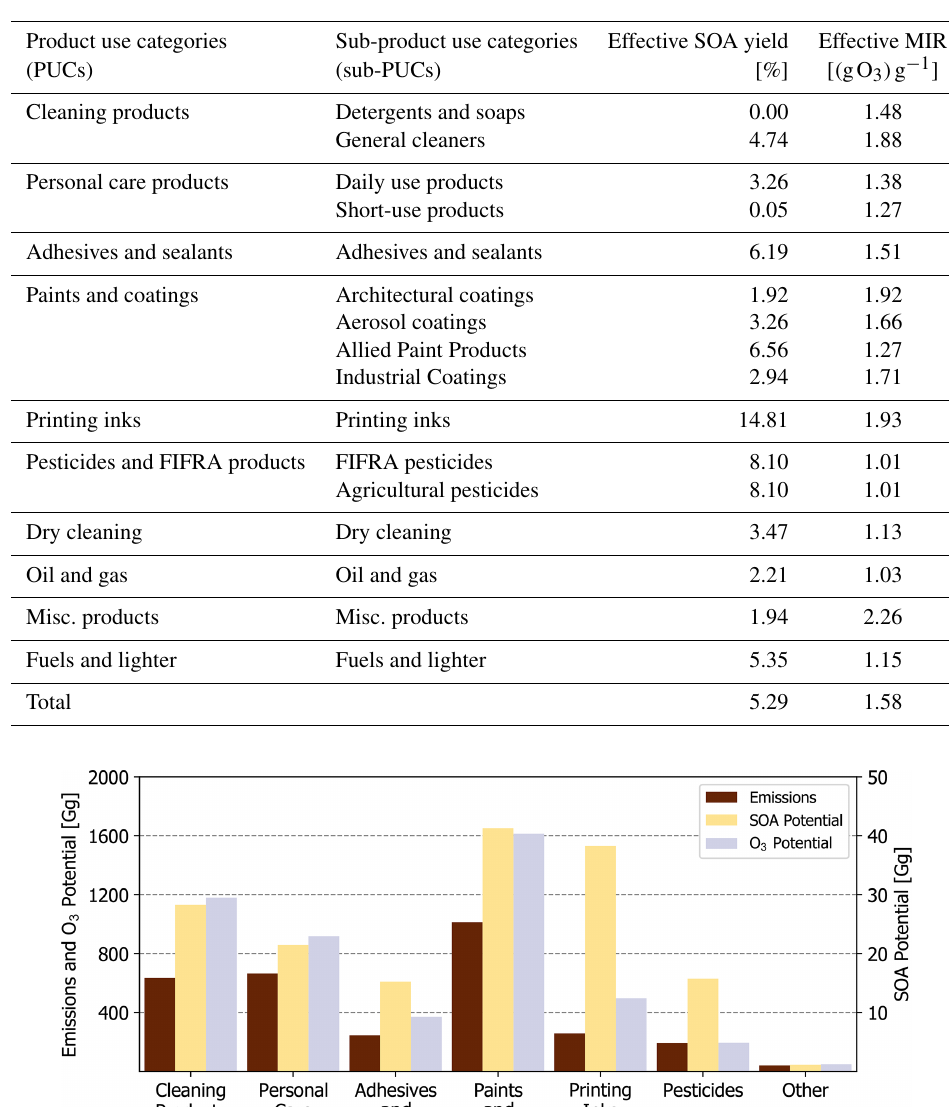
Table 4. The national effective SOA yield and MIR for all sub-PUCs. These results are plotted in Fig. S7.